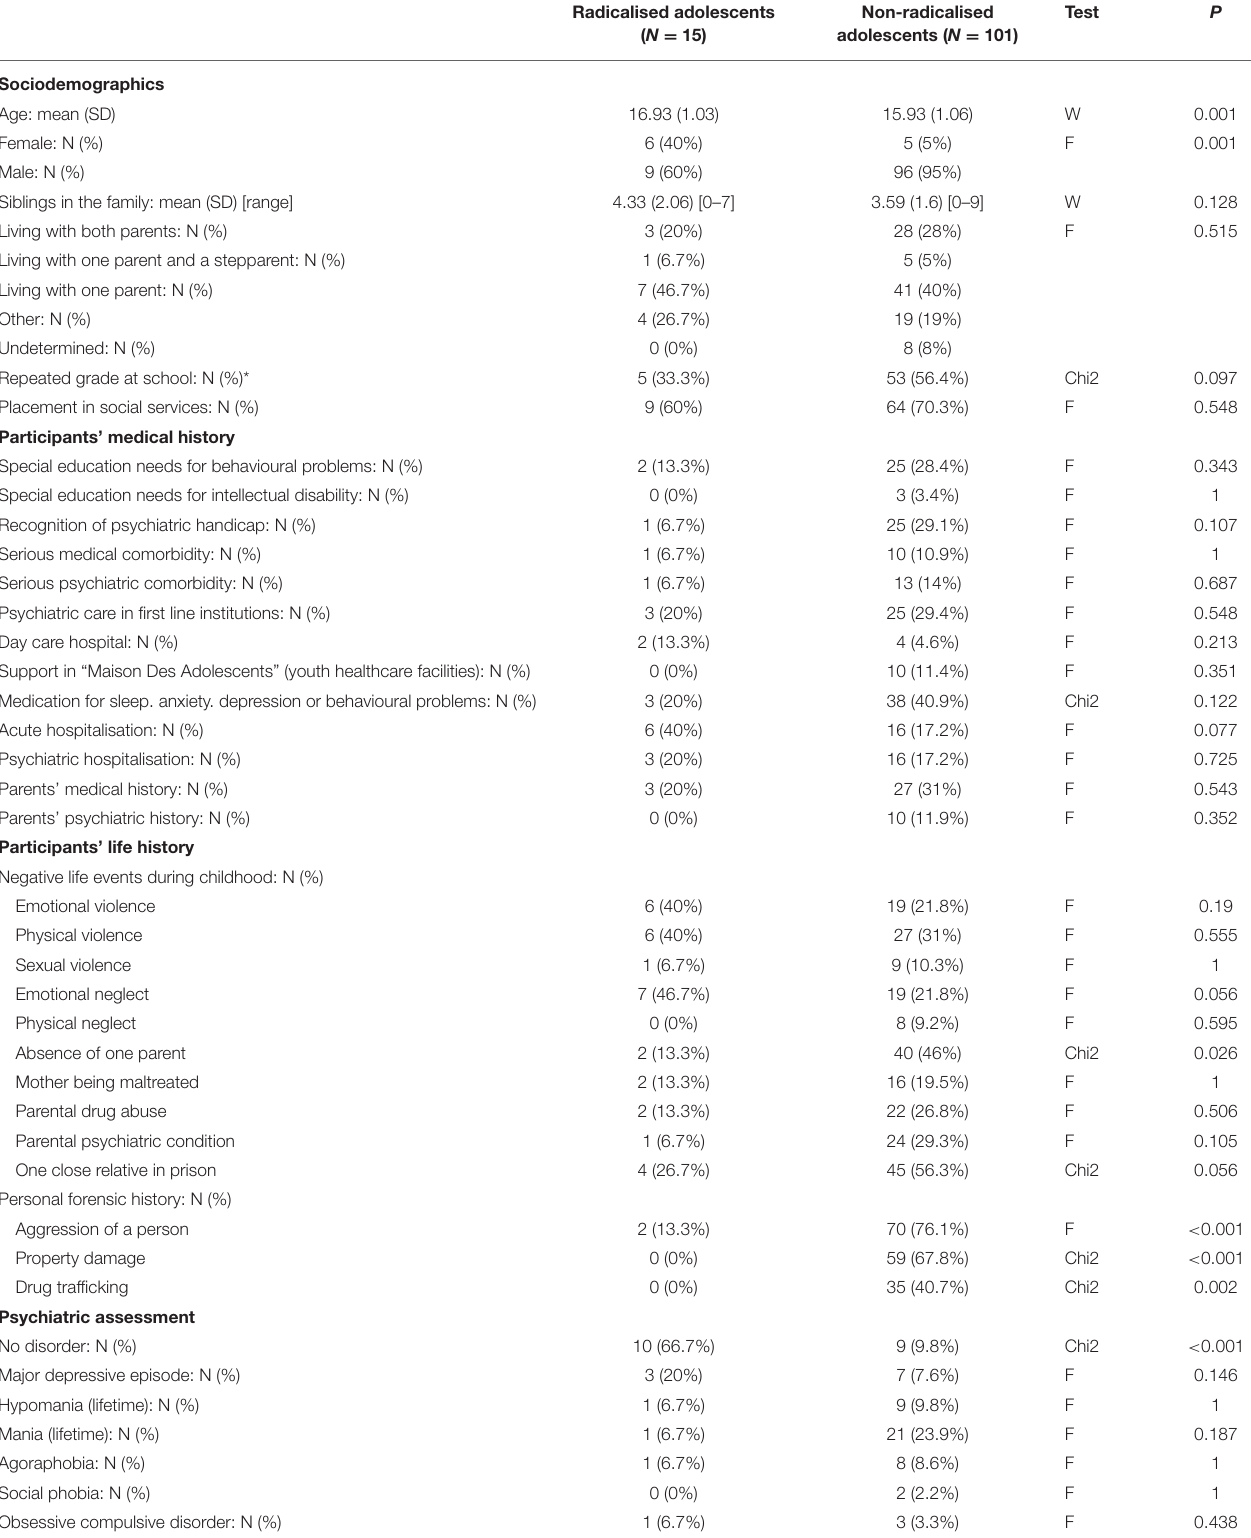
TABLE 2 | Adolescents engaged in radicalisation and terrorism activities ( N = 15) compared to adolescents engaged in other delinquent acts ( n = 101) in 2018 in France.